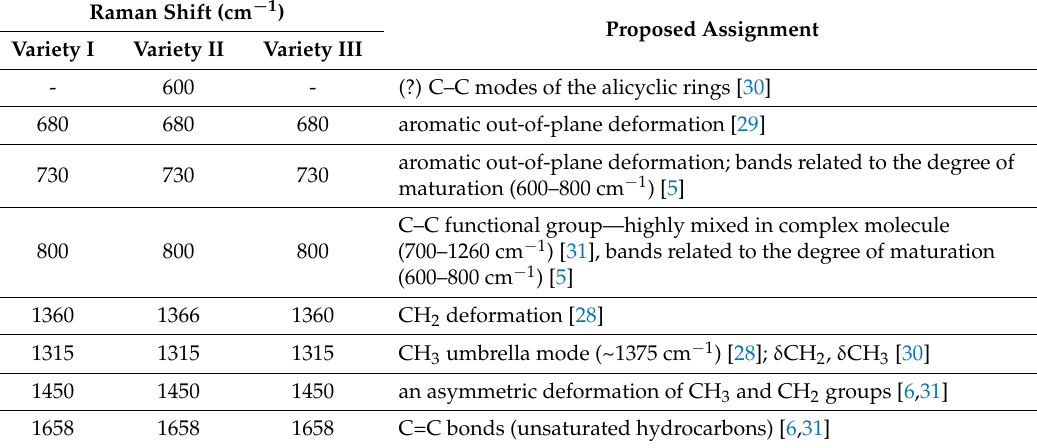
Table 3. FT-Raman band